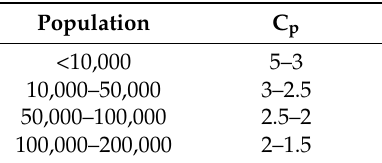
Table 3. Peak flow factor [19].